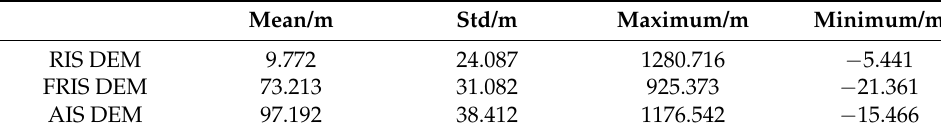
Table 3. Elevation statistics of RIS, FRIS, and AIS DEMs.